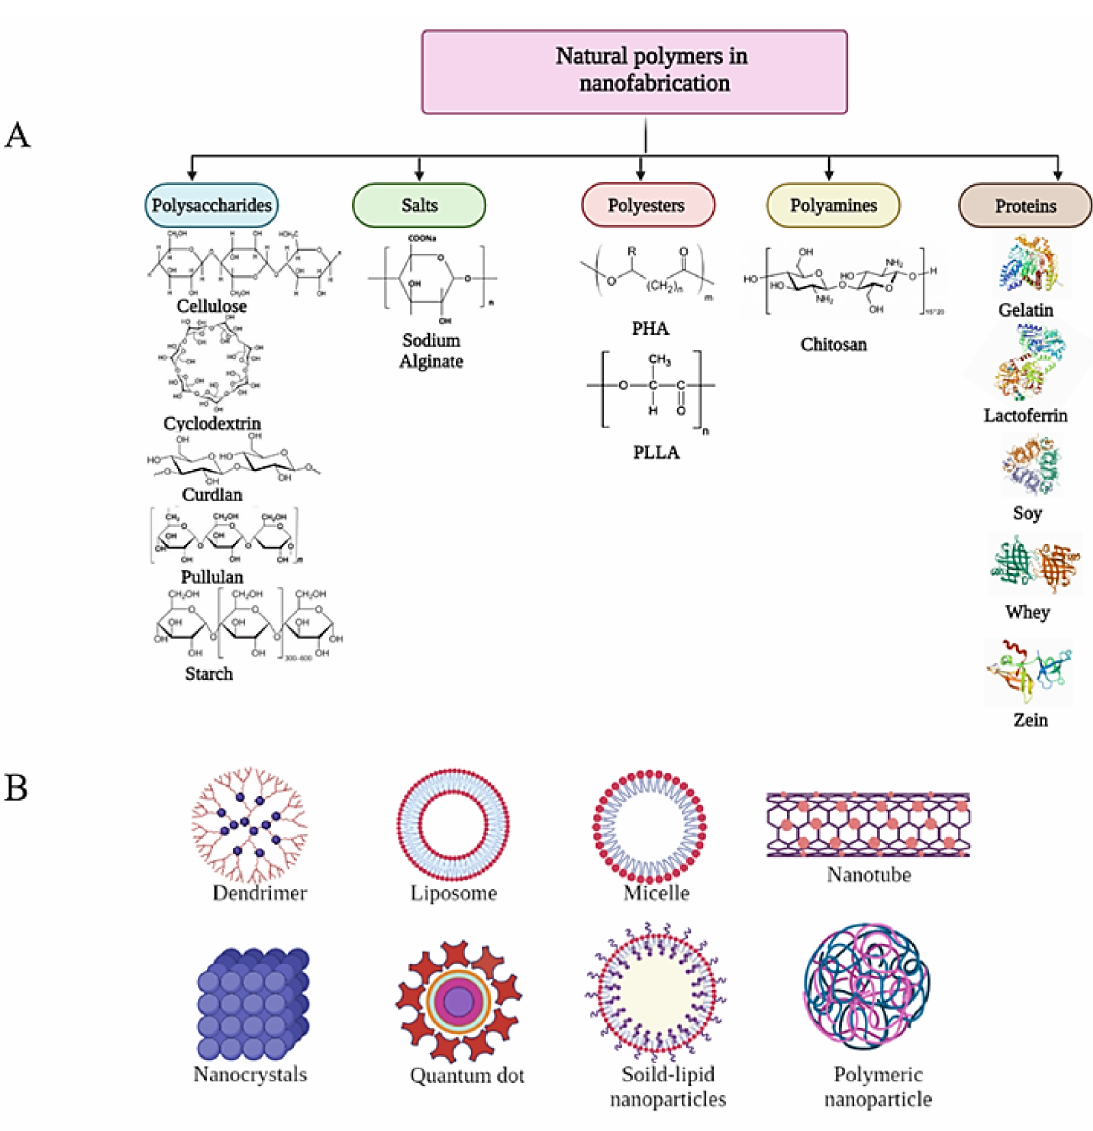
Figure 1. Classification of natural polymers utilized in NMs fabrication ( A ), and their potential structures for bioactive compounds encapsulation ( B